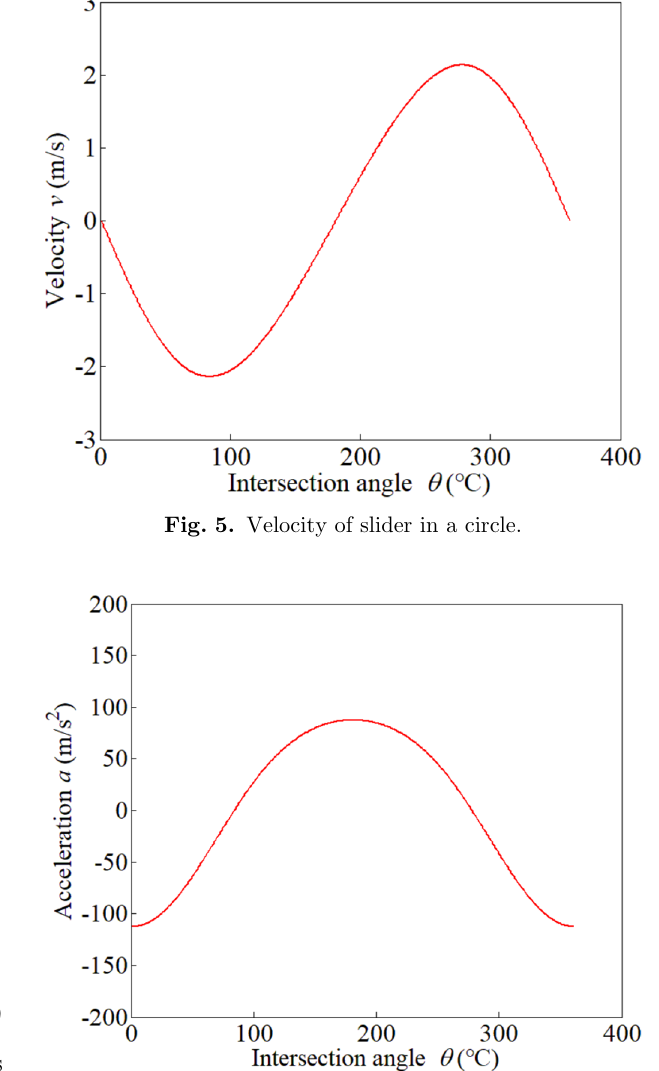
Fig. 6. Acceleration of slider in a circle.